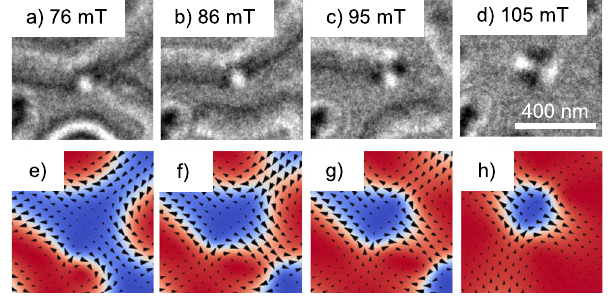
Fig. 5 Nucleation process of antiskyrmions. a – d Nucleation process of an antiskyrmion starting from a crossing point of three stripes without chirality ( a ) imaged by LTEM. b , c show the crossing point with only two and one stripe connected after the fi eld was increased to 86 and 95 mT, respectively. The crossing point resembles a Bloch line and acts as the nucleation point of the antiskyrmion after the fi nal stripe shrank down at 105 mT ( d ). As a comparison, the nucleation process in the micromagnetic simulations is displayed in ( e – h ). The simulation parameters are the same as in Fig. 4. A very similar process is